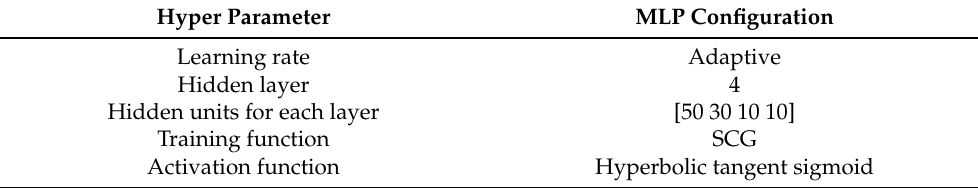
Table 3. MLP network model configuration for C 0 and C 1 estimation.